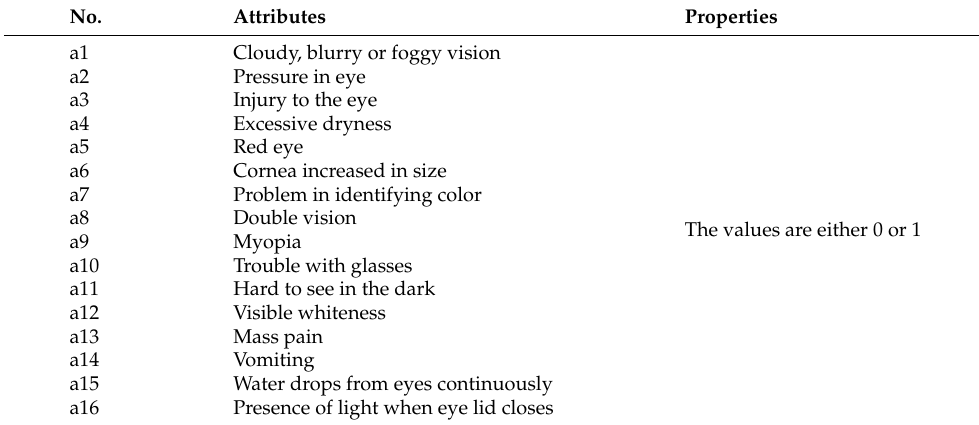
Table 2. Attributes used for data